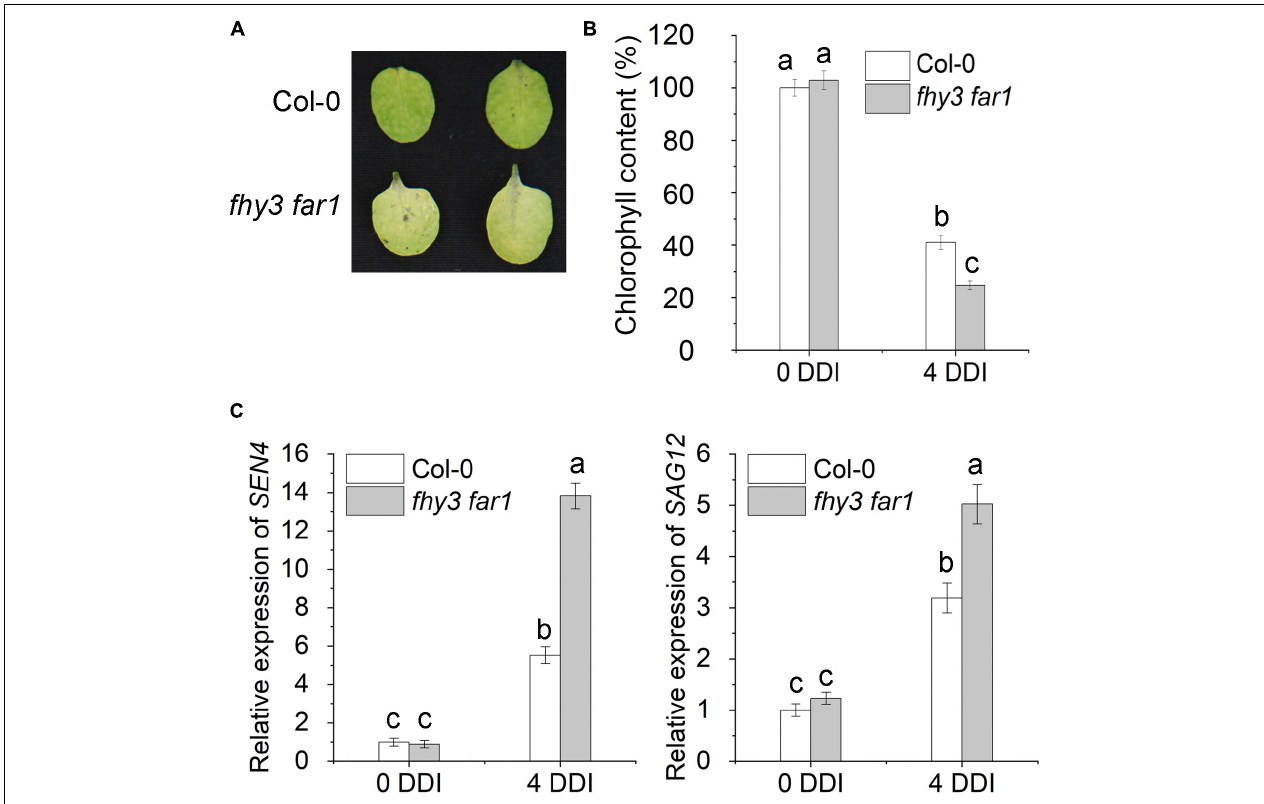
FIGURE 1 | FHY3/FAR1 negatively regulates leaf senescence upon darkness induction. (A) The senescence phenotypes of the detached leaves of 4-week-old Col-0 wild type and fhy3 far1 double mutant plants incubated under darkness for 4 days (4 DDI). (B) The chlorophyll content of the fourth leaves in (A) . Error bars represent SD ( n = 6). Letters indicate significant differences by two-sided LSD test ( p < 0.05). (C) Quantitative RT-PCR analysis of SEN4 (left) and SAG12 (right) gene expression in the fourth leaves of Col-0 and fhy3 far1 without (0 DDI) or with darkness induction for 4 days (4 DDI). Error bars represent SD ( n = 3). Letters indicate significant differences by two-sided LSD test ( p <